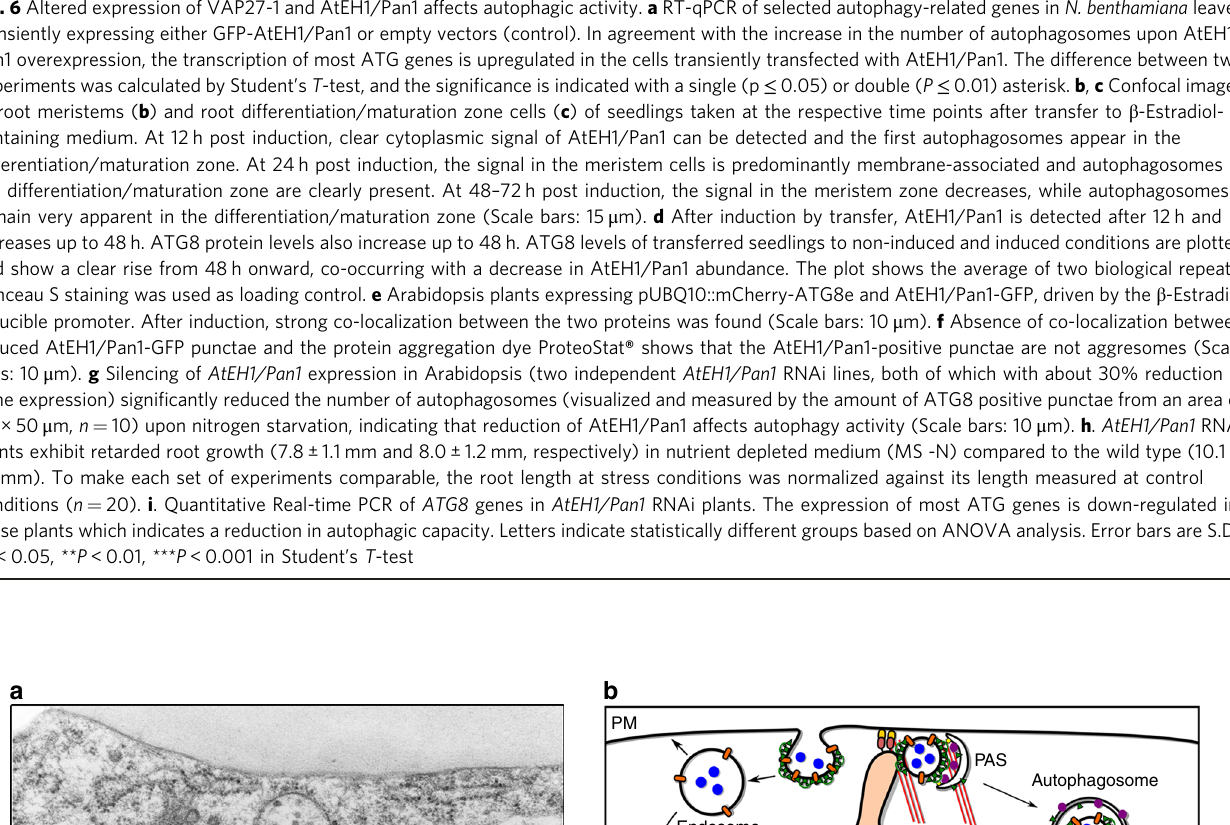
transferred onto stress medium (MS -N or MS -N + Conc A) for extra 2 days. For the plant development assays under control and autophagy induction conditions, sterile seeds were grown on vertical plates containing MS, 1/10MS or MS -N/C (without nitrogen or a carbon source) medium for 5 – 7 days, images were taken and root length was measured using ImageJ.